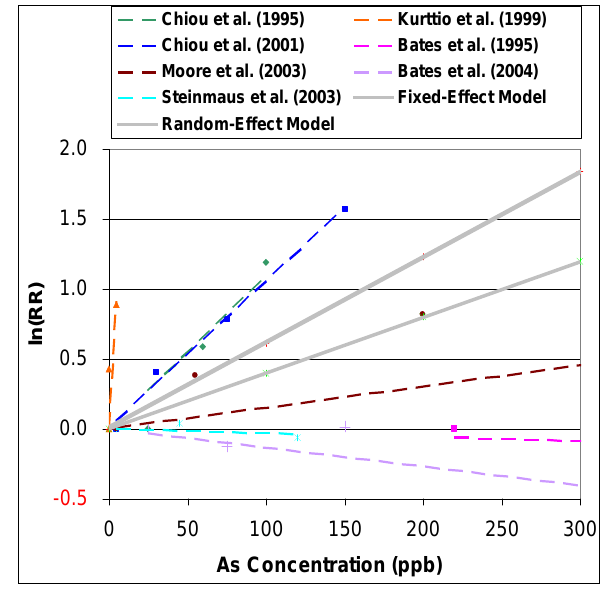
Figure 4: Dose-response relationship of relative risk of bladder cancer for arsenic intake from drinking water by using fixed-effect and random-effect